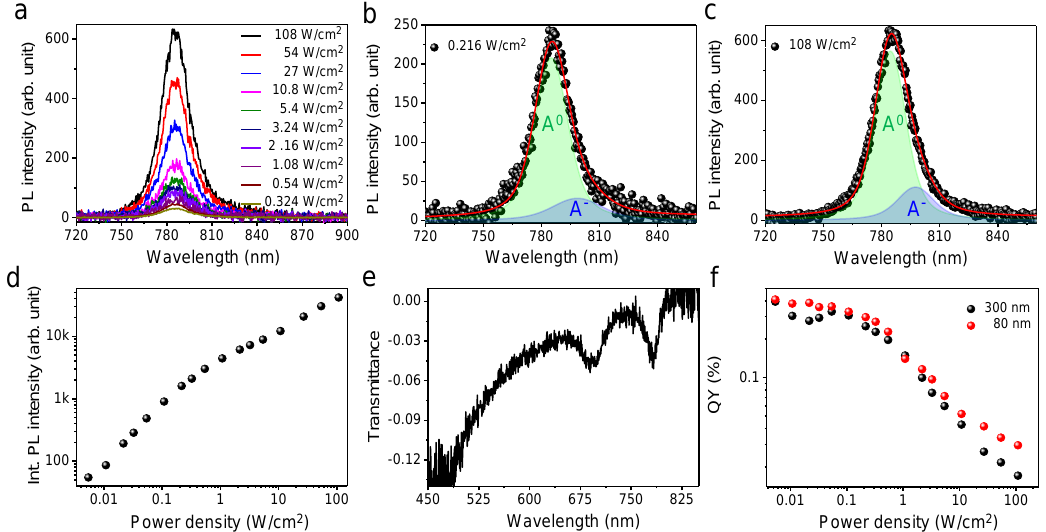
Figure 3. ( a ) Confocal PL spectra of the exfoliated 1L-MoSe 2 on a quartz substrate with various laser intensities. Deconvoluted PL spectra of the exfoliated 1L-MoSe 2 at ( b ) 0.216 W/cm 2 and ( c ) 108 W/cm 2 . ( d ) Integrated PL intensity of 1L-MoSe 2 as a function of laser intensity. ( e ) Representative transmittance spectrum of 1L-MoSe 2 . ( f ) Plot of the QYs of 1L-MoSe 2 as a function of laser intensity, estimated using 80- and 300-nm-thick reference specimens.